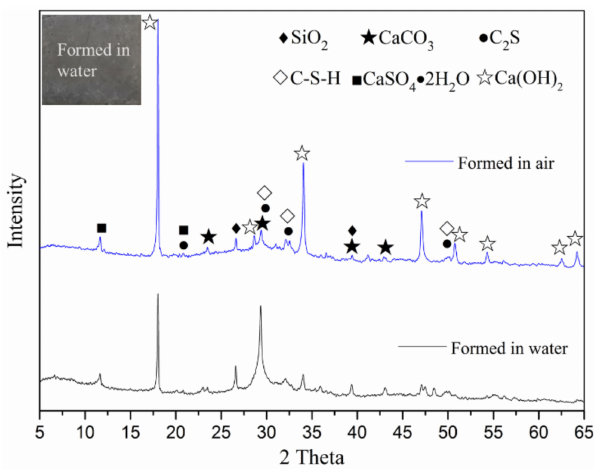
Figure 10. XRD patterns of specimens formed in water and air with a volume ratio of